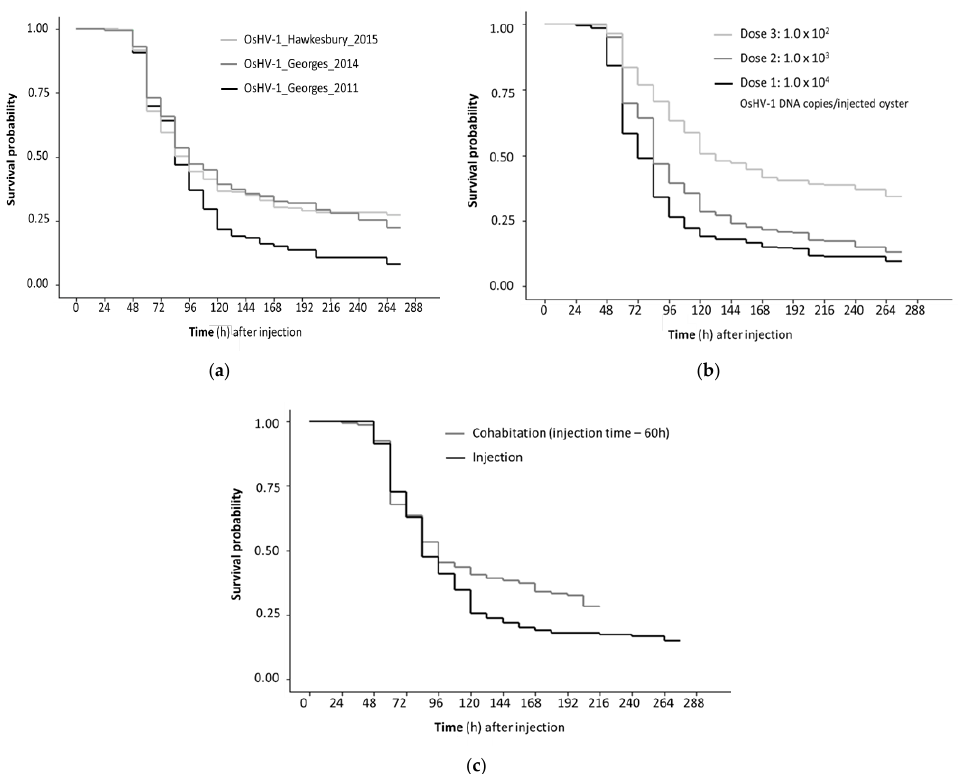
Figure 2. Kaplan Meyer survival curves for three OsHV-1 isolates after Pacific oysters were challenged by injection and cohabitation. Survivor probability was determined using secondary inoculae prepared as tissue homogenates from Pacific oyster challenged by injection with archived field samples. ( a ) Comparison of OsHV-1 isolates collected at different times from two different rivers; ( b ) Comparison of challenge method with time adjusted by −60 h for cohabitating oysters to allow for the longer incubation period with exposure from injected oysters; ( c ) Comparison of different doses used for the half of the oysters in each replicate tank that were challenged by injection. Data from replicate tanks were pooled. Each factor was significant (log rank test p < 0.05). Table 2. Total cumulative mortality in duplicate tanks for each isolate with three different doses for injection. Approxi- mately half of the oysters in each tank were challenged by injection and the remainder were challenged by cohabitation in the same tank.